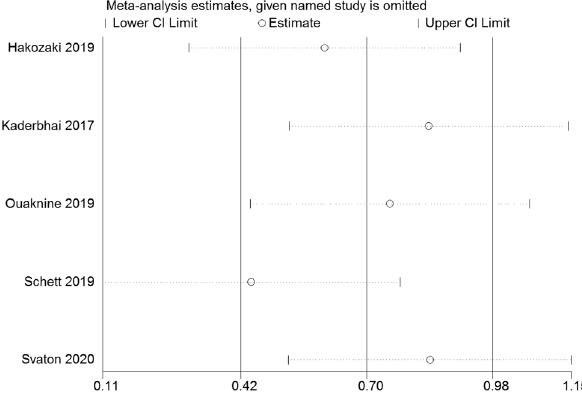
Figure 8: Sensitivity analysis of the studies assessing PFS.